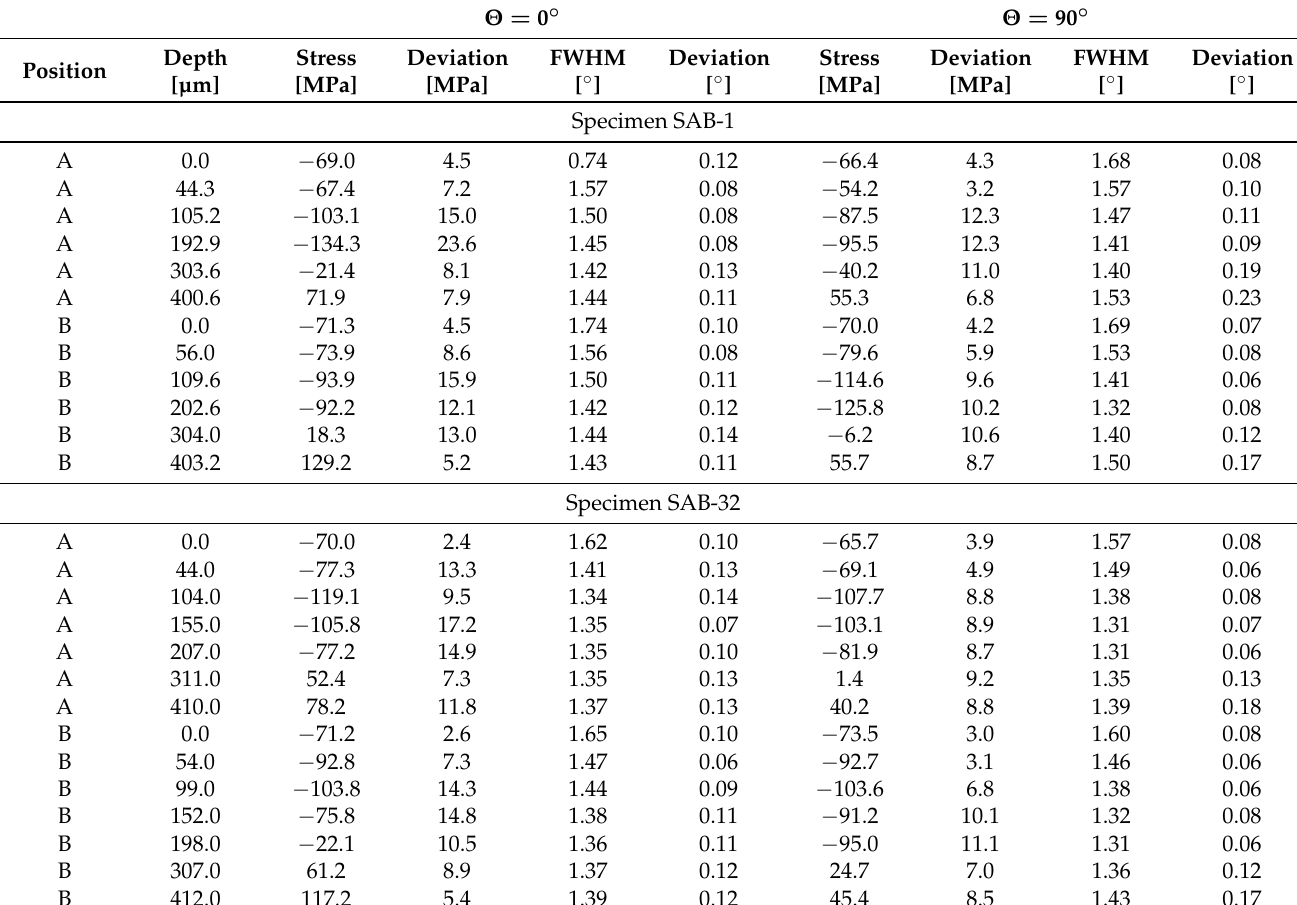
Table A1. Measured residual stresses on sandblasted samples SAB-1 and